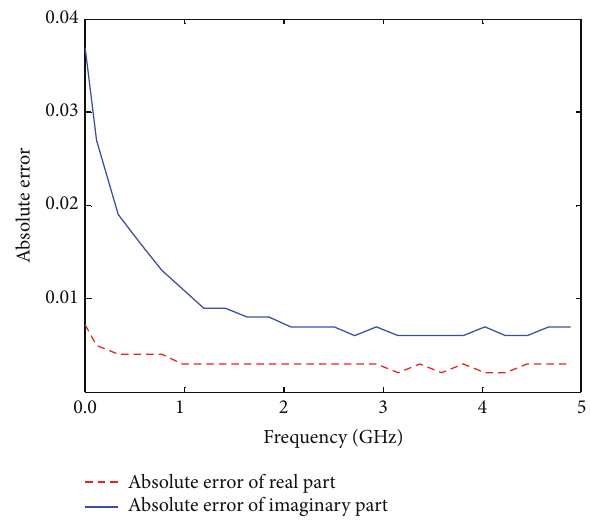
Figure 8: Absolute error values of real part and imaginary